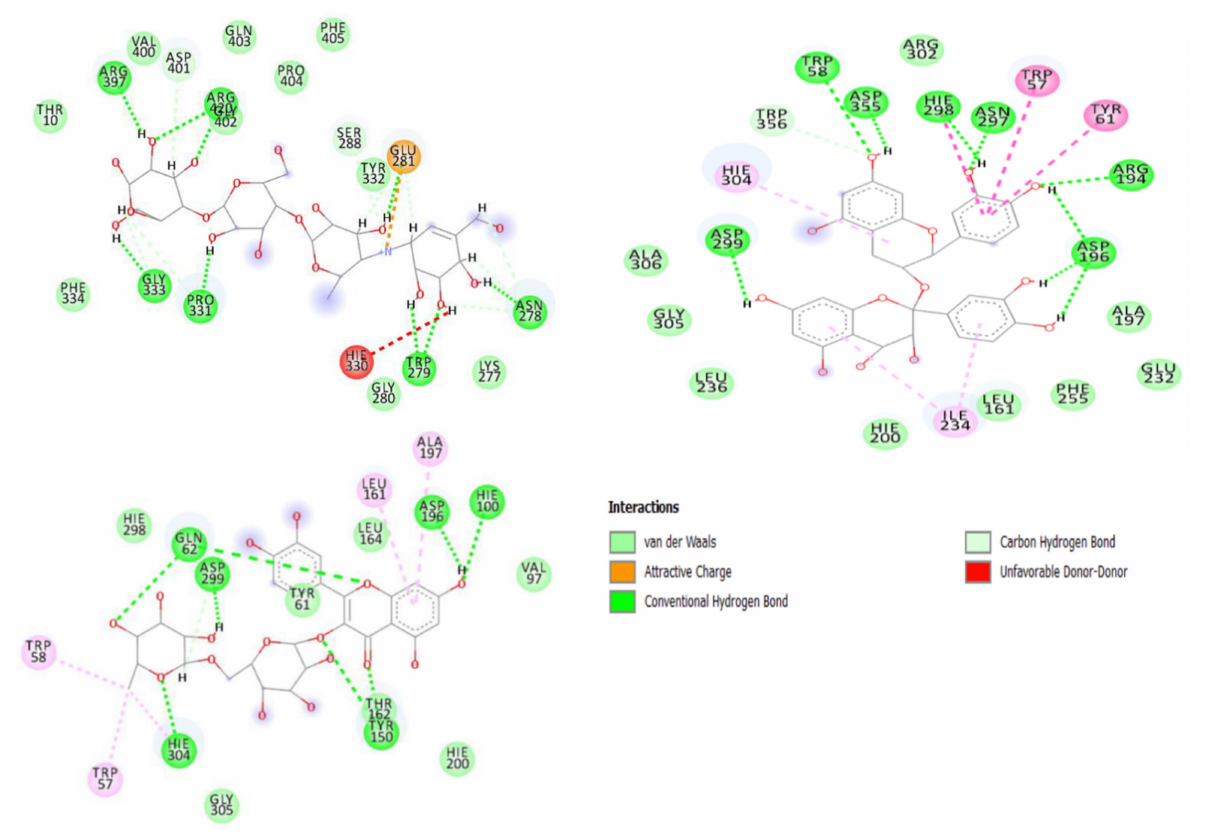
Figure 5. Interaction types and plots between phenolic compounds, standard drug and alpha-amylase. ( A ): Acarbose (ACB); ( B ): Procyanidin (PDN); ( C ): Rutin